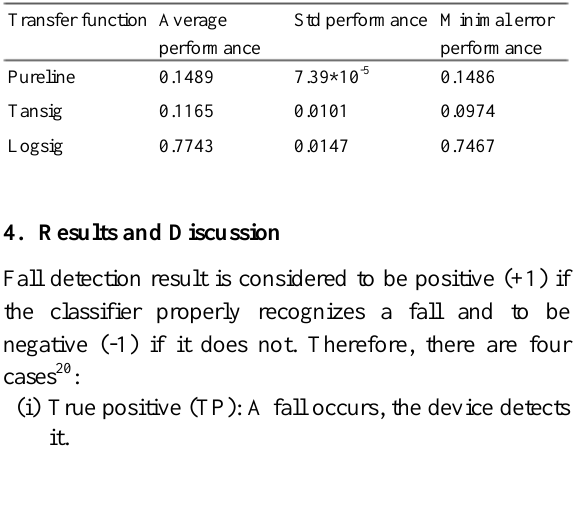
Table 3. Performance of trained MLP with different transfer